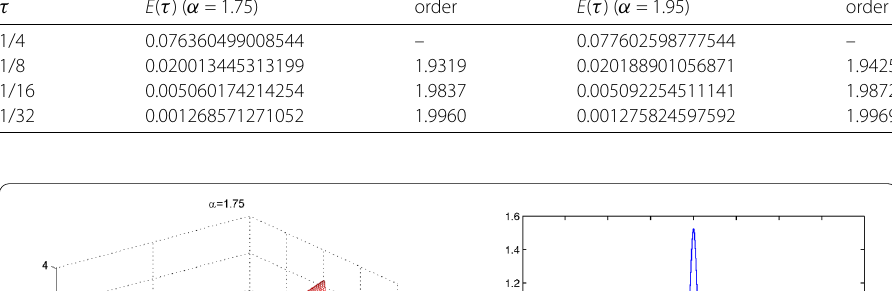
Table 2 The convergence order in temporal direction with α = 1.75,1.95, h = 1/128 at time t = 1 τ E ( τ ) ( α = 1.75)